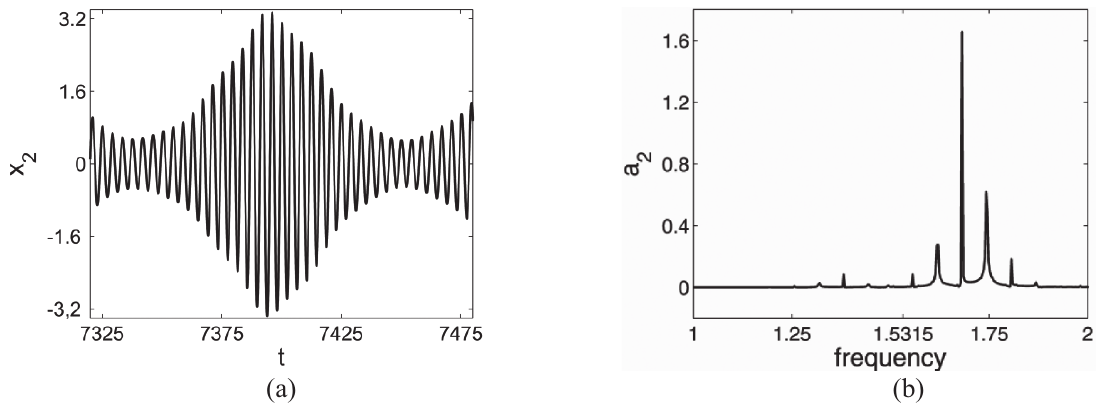
Fig. 7. Time series (a) and FFT (b) for quasi-periodic controller response; x 0 = 0.01, Ω = 2.75.